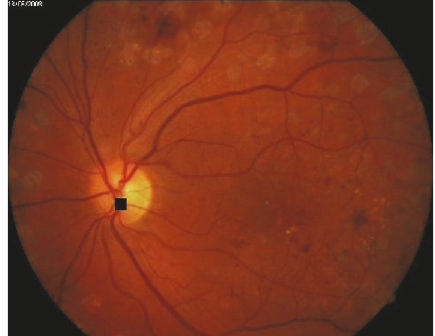
Figure 5: Image 𝐼 𝑔 number (29) in data set with its nonoverlap patches entropies.